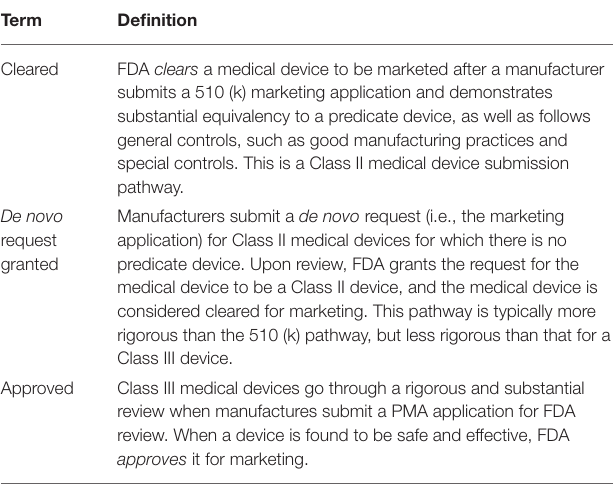
TABLE 2 | Terminology defined: US regulatory